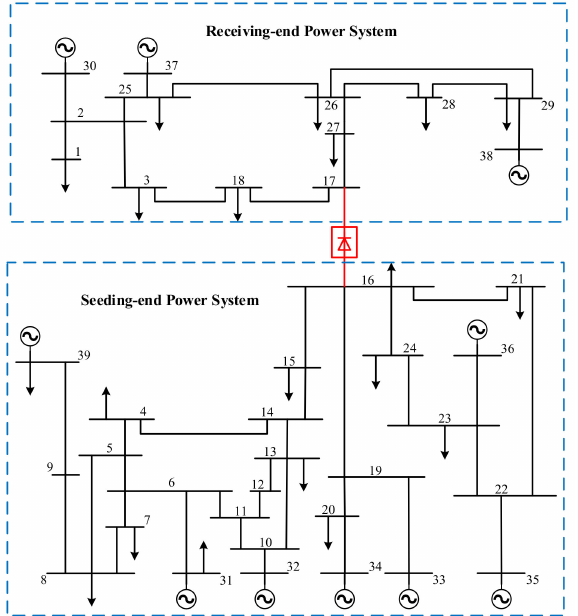
Figure 12. AC/DC asynchronous interconnection power